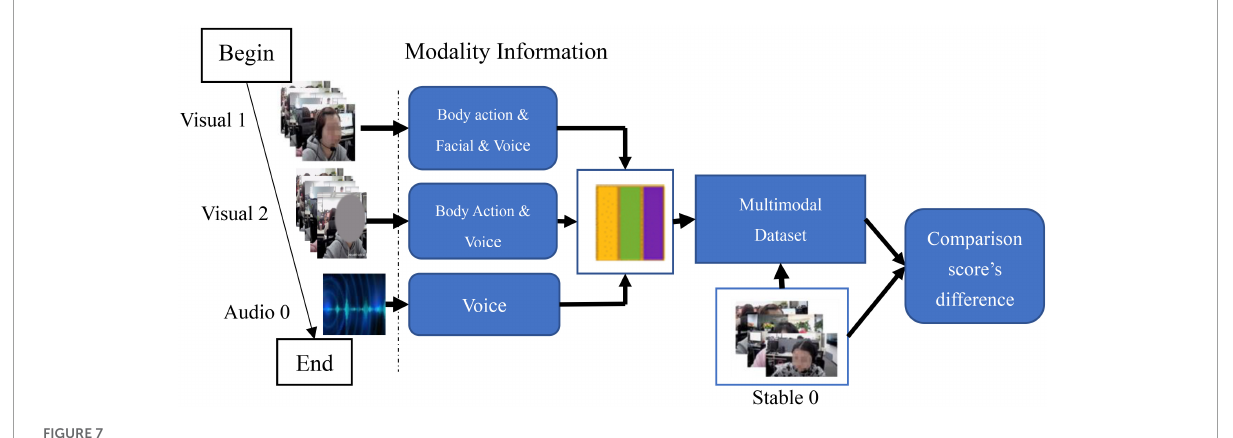
FIGURE7 Scoring flowchart for multimodal dataset of